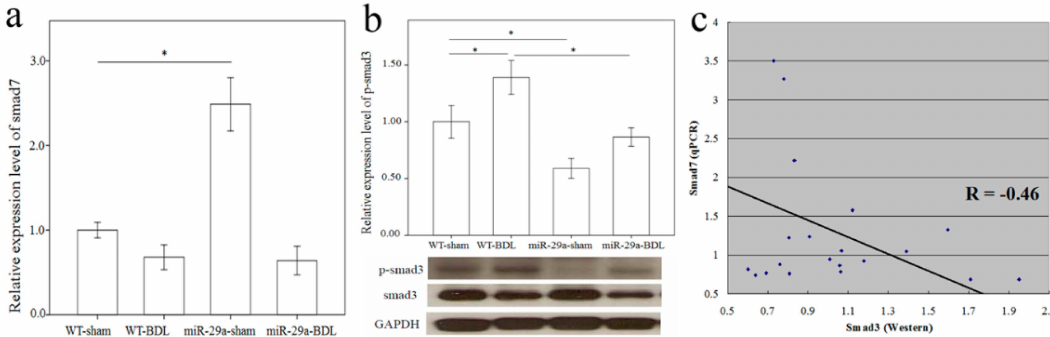
Figure 3. Comparison of the mRNA levels of Smad7 ( a ) and protein levels of Smad3 ( b )